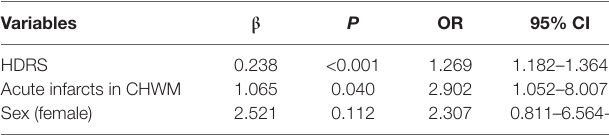
TABLE 3 | Correlates of PSA in the acute stage of ischemic stroke.